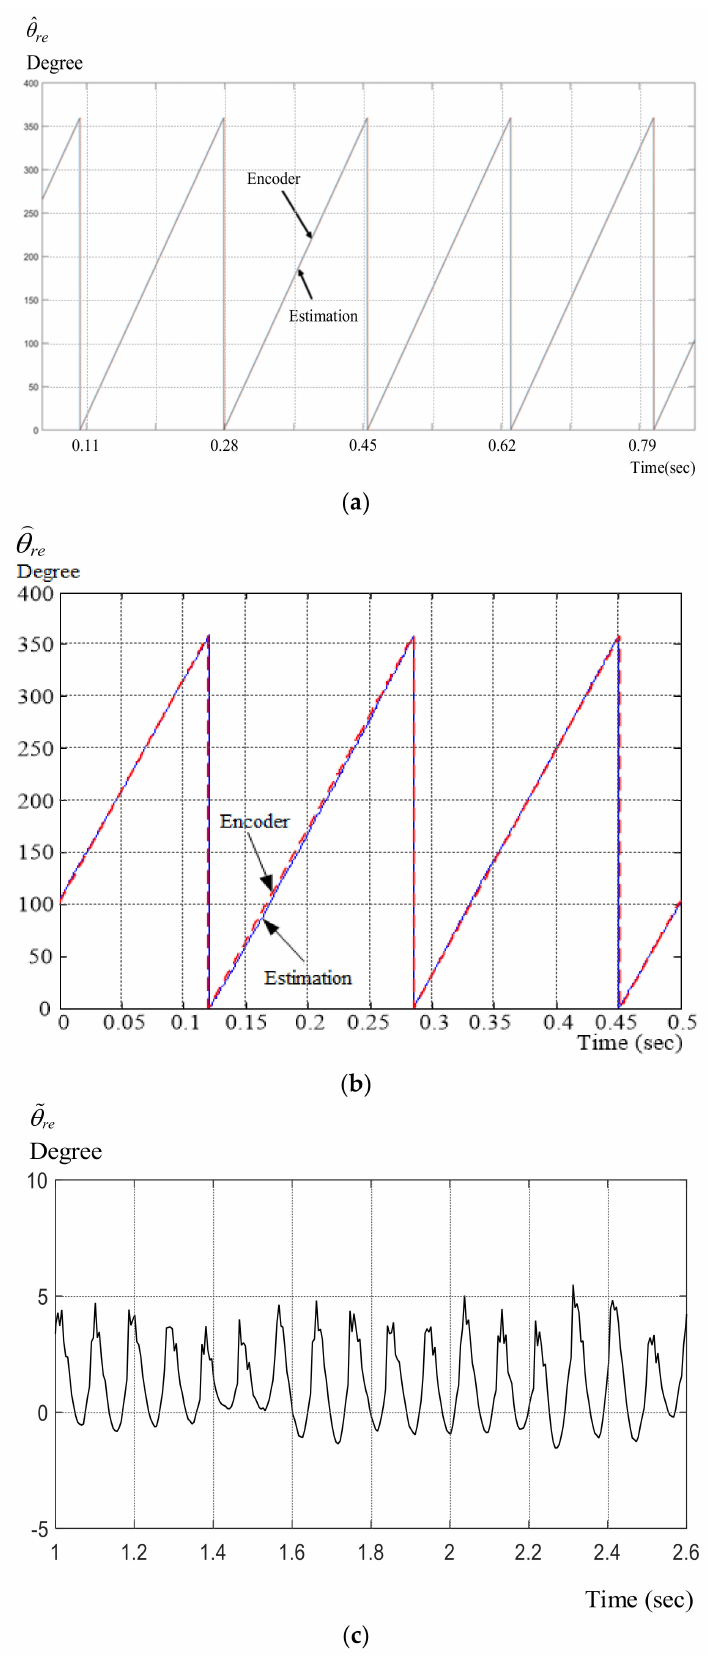
Figure8. Responsesat500rpm. ( a )Simulatedposition; ( b )measuredposition; ( c